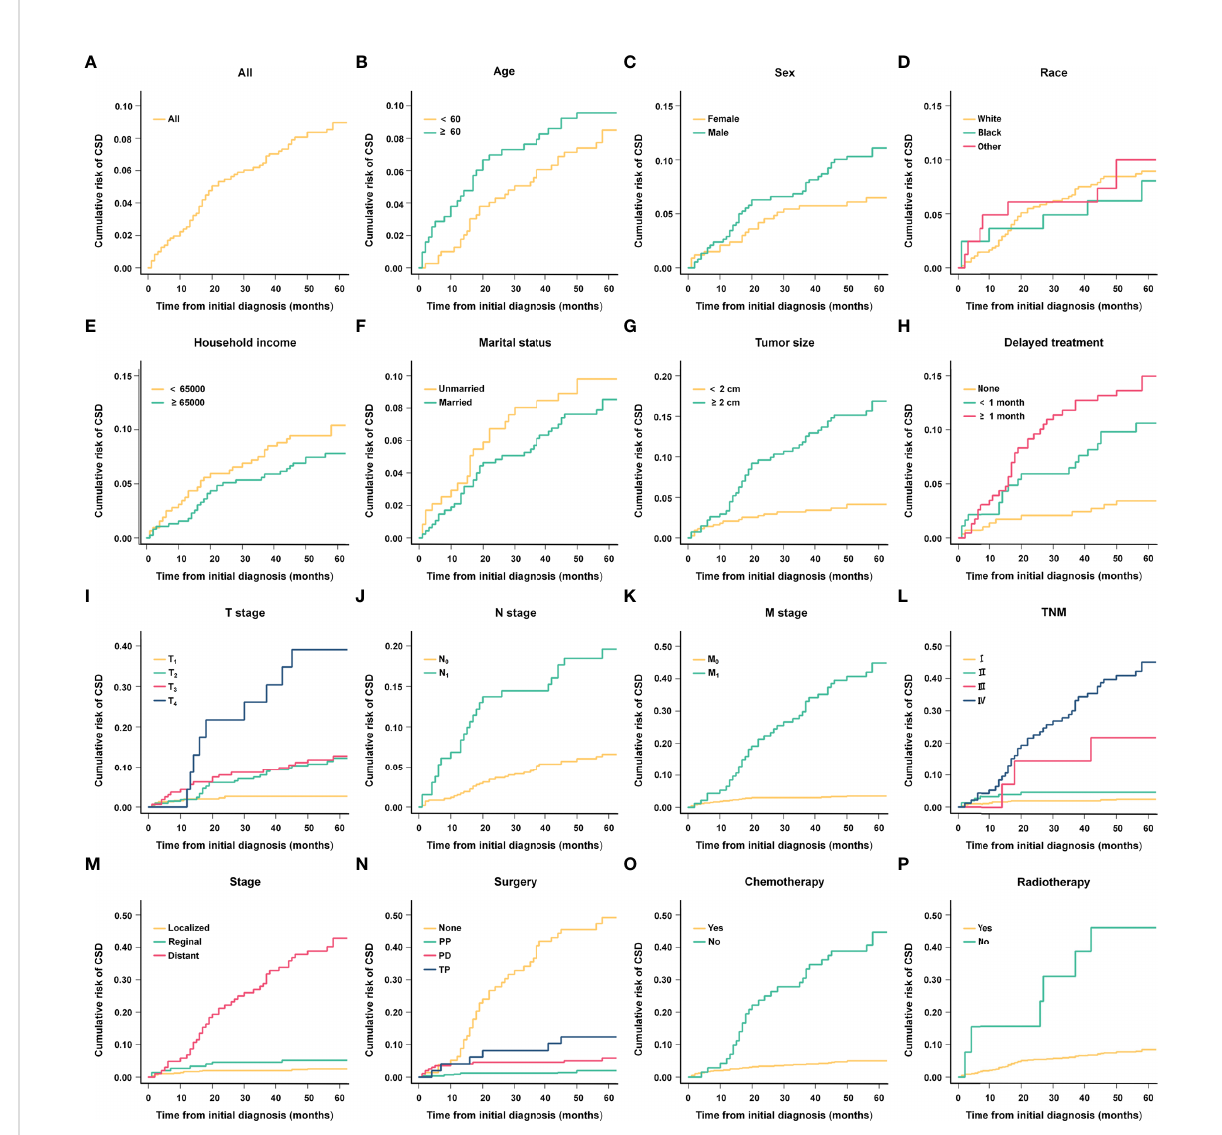
FIGURE 6 Cumulative risk curves of CSD in different subgroups. (A) All; (B) Age; (C) Sex; (D) Race; (E) Household income; (F) Marital status; (G) Tumor size; (H) Delayed treatment; (I) T stage; (J) N stage; (K) M stage; (L) TNM; (M) Stage; (N) Surgery; (O) Chemotherapy; (P)